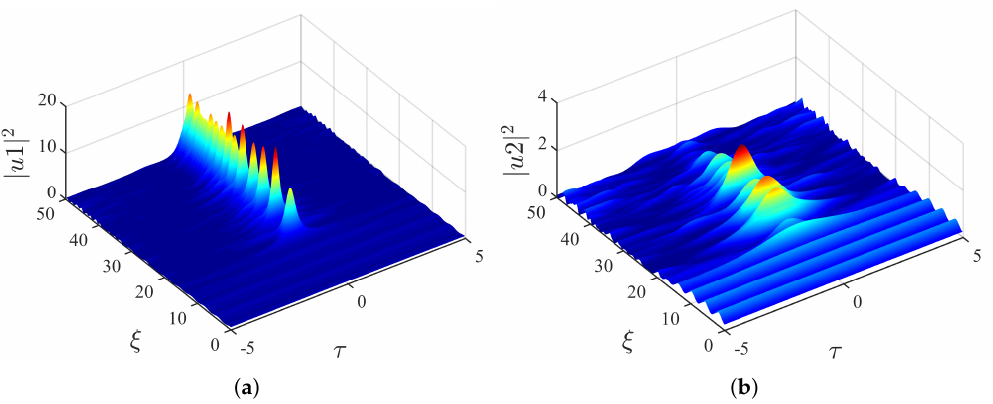
Figure 20. The MI-driven evolution in the bar ( a ) and cross ( b ) channels in the anomalous-GVD regime ( σ = 1) for initial CW amplitudes A 1 = 0.75, A 2 = 0.5 and perturbation parameters a 0 = 0.0009, ω 0 = 1. Other parameters are α = 2, Γ = 1, ρ = 0.01, χ = 0.001 and κ = 1.